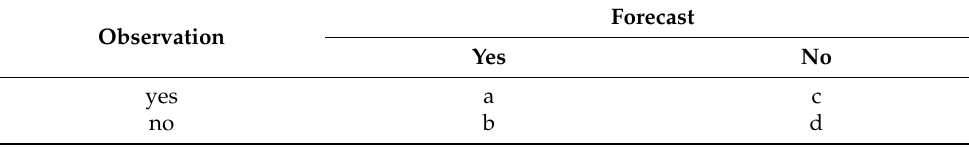
Table 1. A contingency table of forecast and observation events for a selected